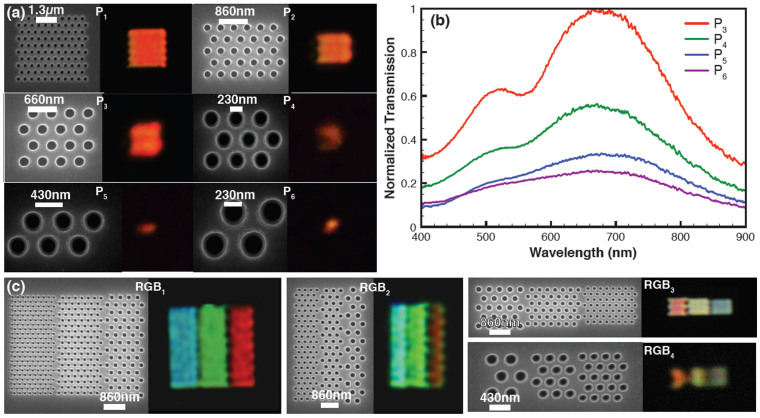
Development of submicron colour filters (a) SEM images of red colour filters of different sizes and the corresponding optical images (P1–P6) (100 × magnification). The filter size varies from 4.53 μm down to 660 nm. The optical images of the submicron scale plasmonic filters mimic the SEM images (pixel boundary errors) (P1–P6) (b) Experimental transmission spectra of the red submicron filters, P3 (1.73 μm × 1.53 μm), P4 (1.3 μm × 975 nm), P5 (1.3 μm × 602 nm), and P6 (660 nm × 602 nm) display a peak at 680 nm (c) SEM images of submicron colour filters with sub-RGB filters. The sub-RGB filter sizes for the red are 1.95 μm × 5 μm (RGB1), 875 nm × 5 μm (RGB2), 1.95 μm × 1.72 μm (RGB3) and 875 nm × 975 nm (RGB4). The corresponding optical images (100 × magnification) display pixel stitching errors at the boundaries (RGB1–RGB4).